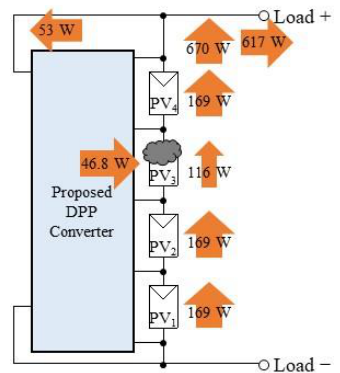
Figure 16. Power redistribution image in laboratory testing.